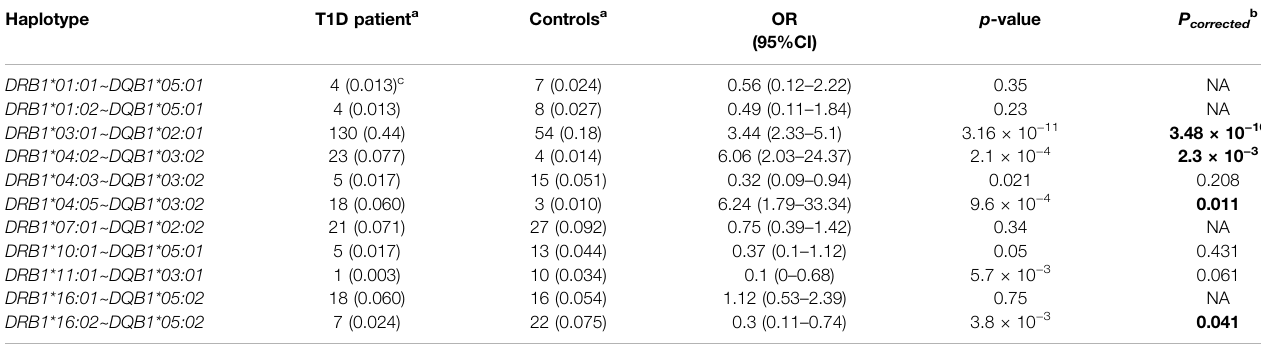
TABLE 4 | Association of DRB1-DQB1 Haplotypes with T1D in Emirati study subjects. Haplotype T1D patient a